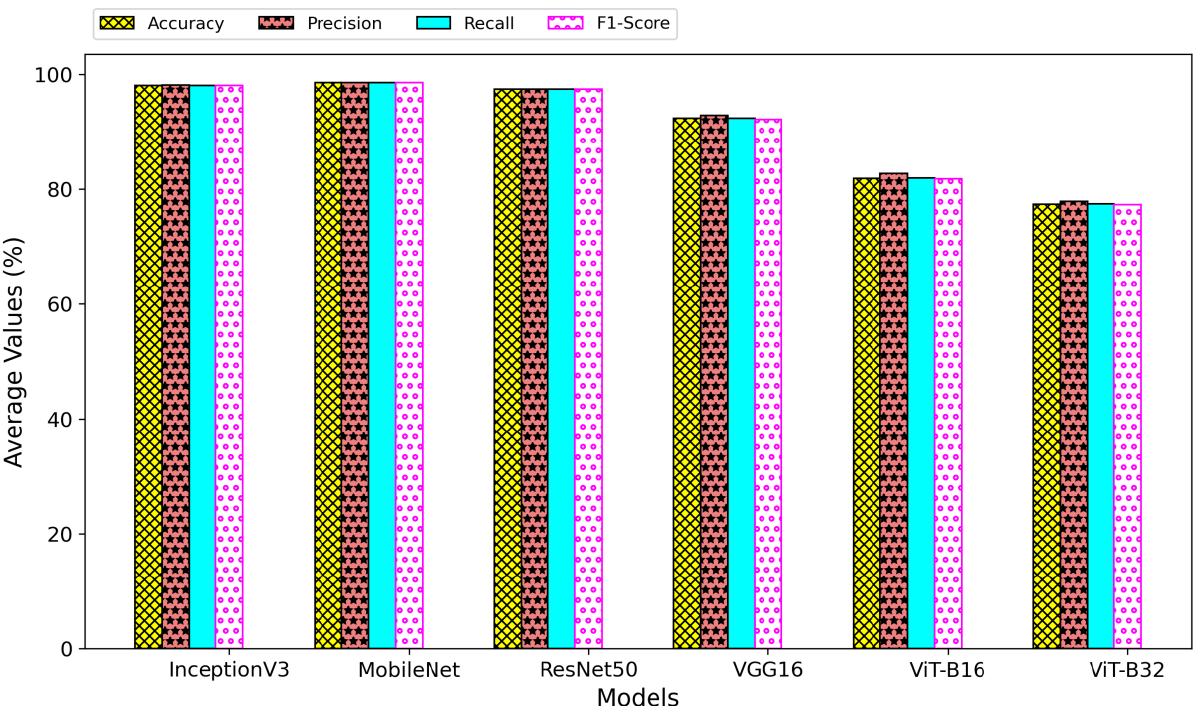
Figure 9. Average of each model’s performance regardless of the image representations.